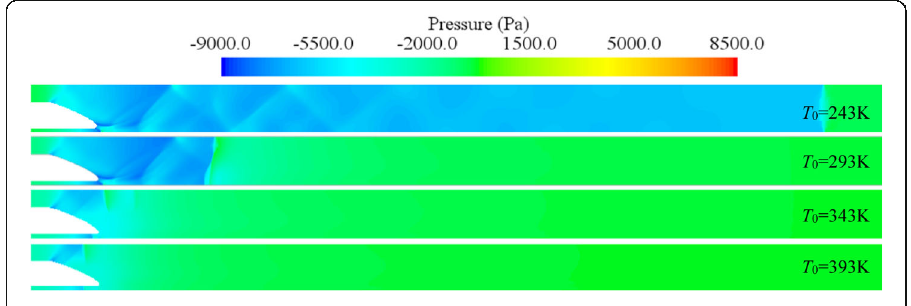
Fig. 19 The contours of pressure in the wake area at different T